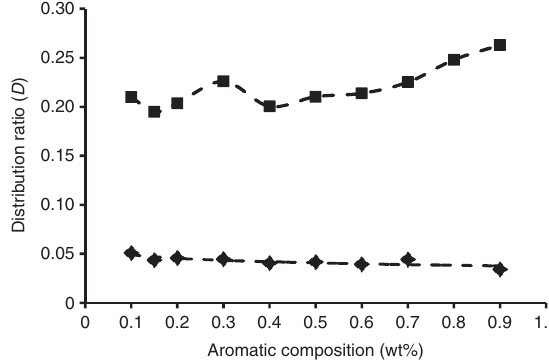
Figure 3: The distribution ratio at 25 ° C as a function of the mass fraction of the aromatic in the raffinate for DES1 (diamond symbols) and DES2 (square symbols).